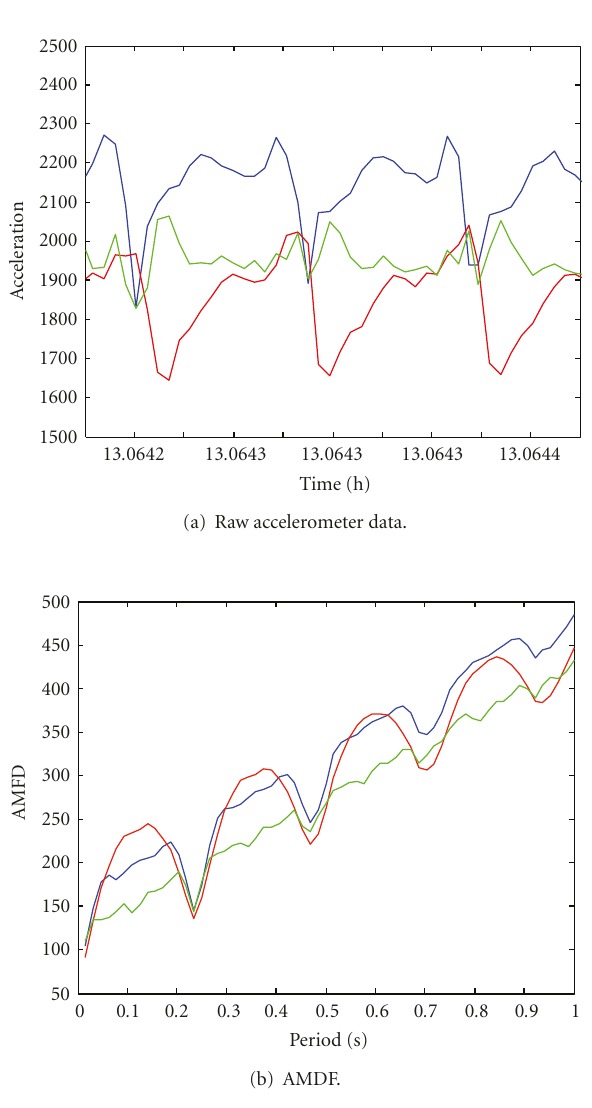
Figure 20: Accelerometer data and AMDF analysis of mountain lion data since October 17, 2008. Time is hours since midnight GMT. See Figure 19 for the location, where the data was